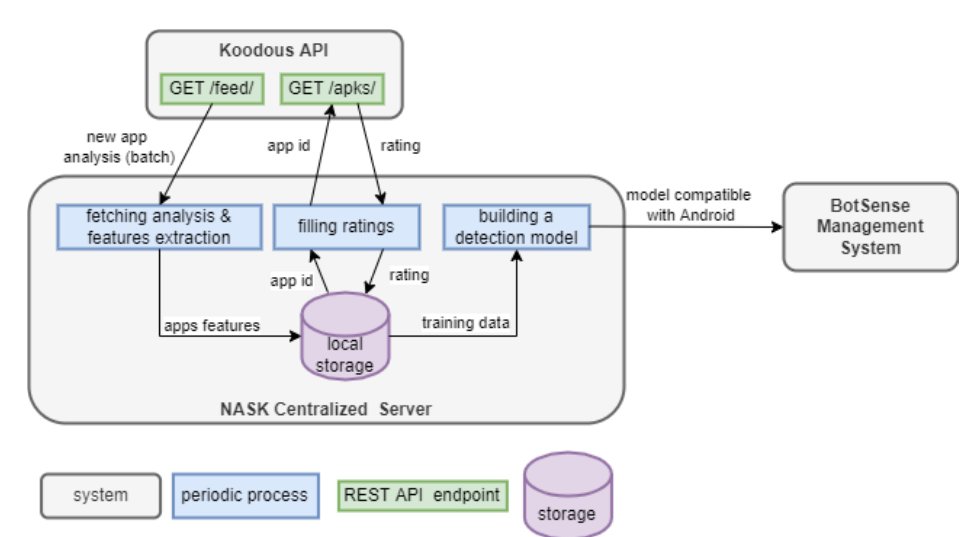
Figure 5. The architecture of the automated model generation